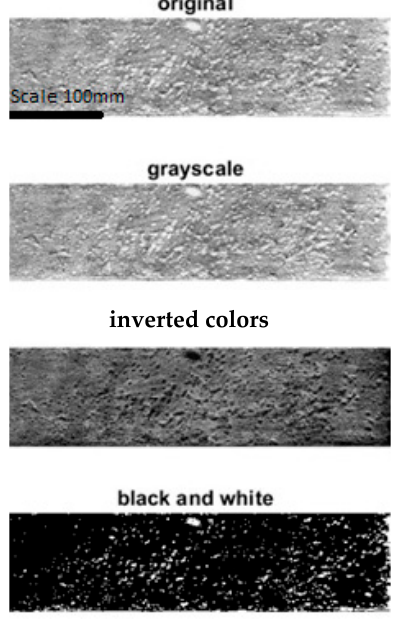
Figure 6. Image conversion.